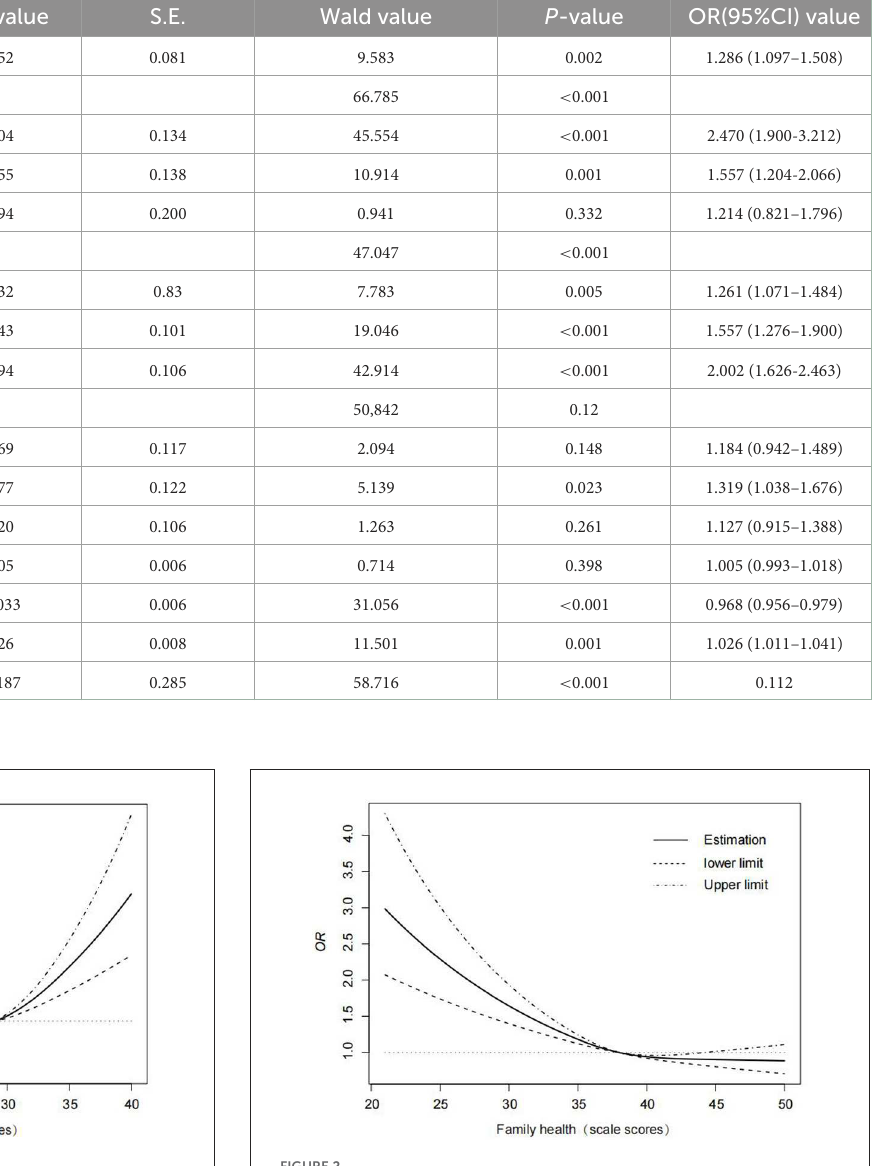
FIGURE1 Trend of the effect of self-efficacy on HPV vaccination.